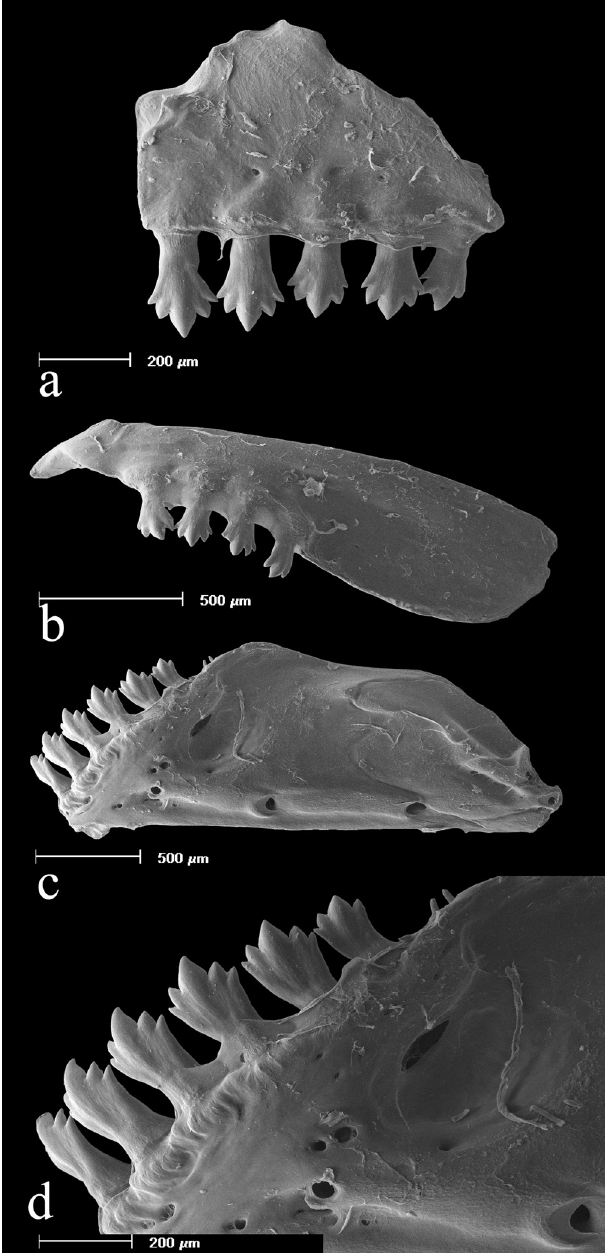
Fig. 3. Scanning Electron Microscopy (SEM) images of dentition of Serrapinnus potiguar , paratype, UFRGS 9216, 29.1 mm SL: ( a ) right side premaxilla; ( b ) maxilla; ( c ) dentary; ( d ) detail of the